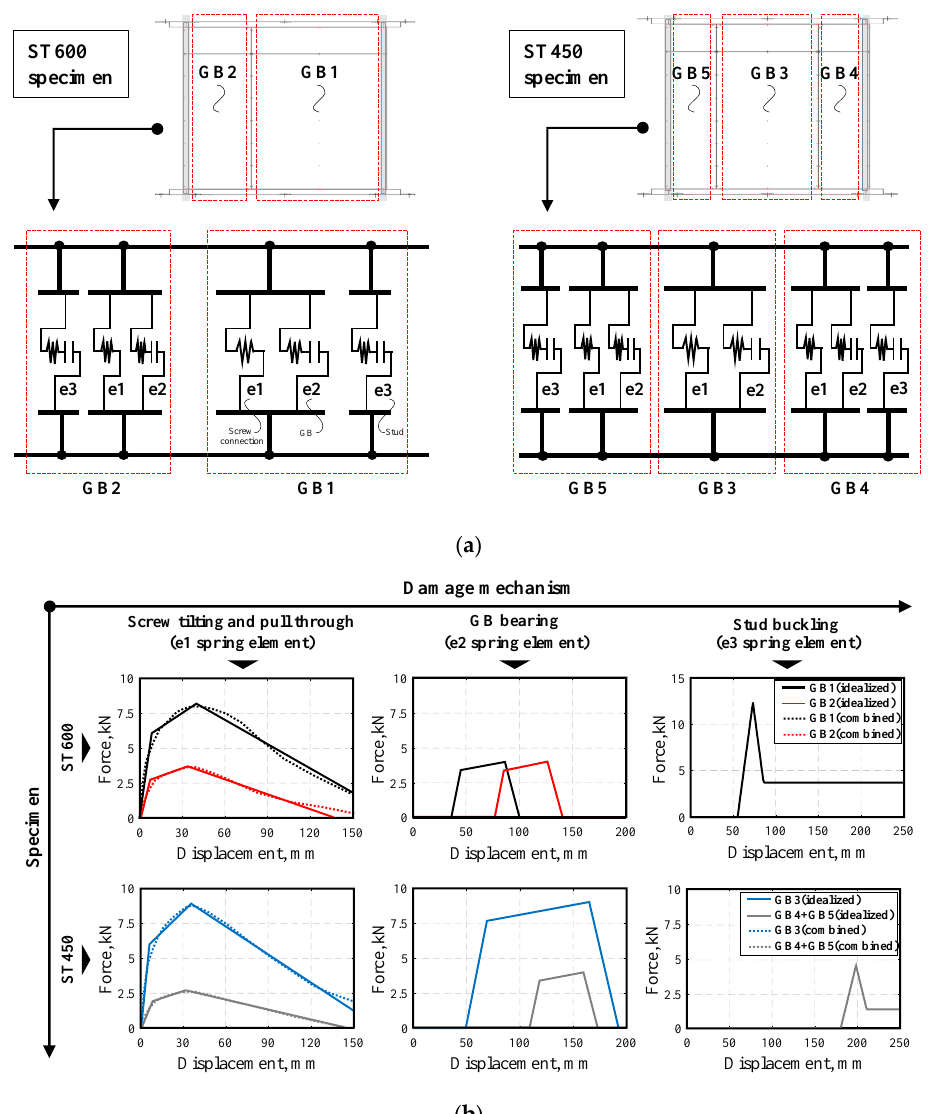
Figure 12. Determination of monotonic behavior of elements consisting of specimens: ( a ) distribution of elements; ( b ) backbone curves.